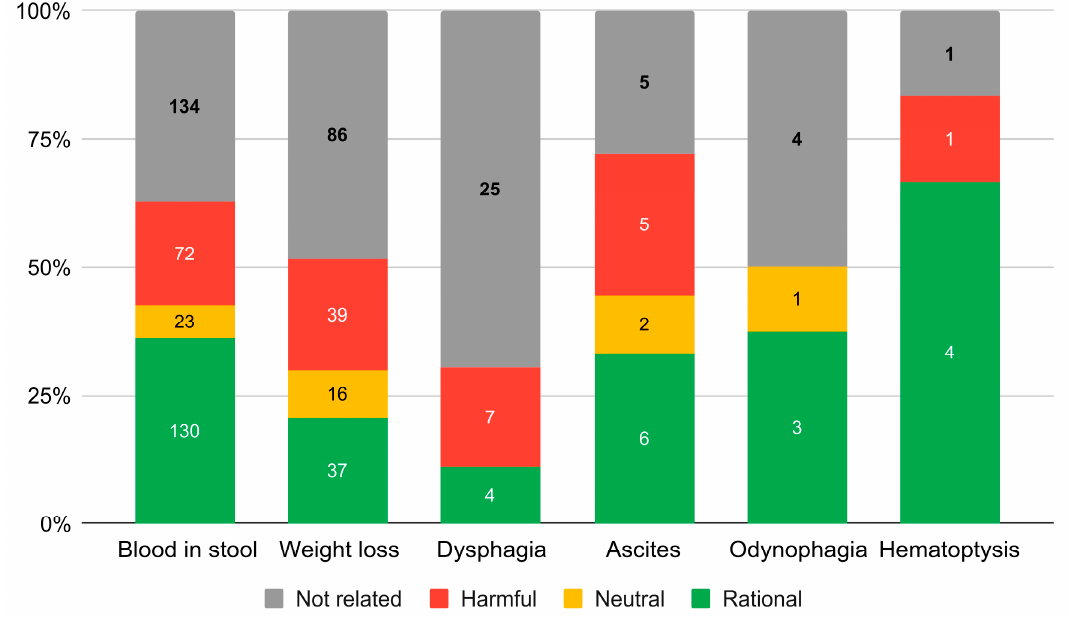
Figure 3. The number of pieces of advice and their characteristics in the initial post about the alarm symptom.